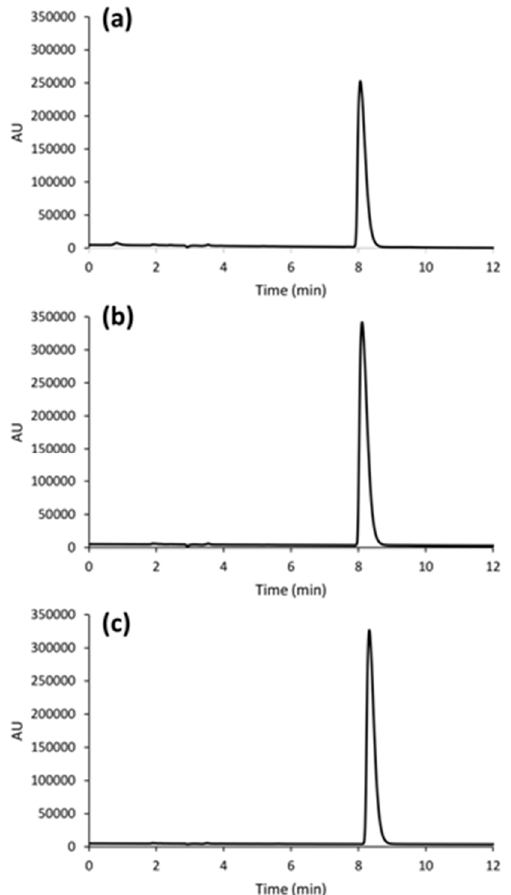
Figure 2. Achiral reversed-phase (RP)-HPLC chromatograms of ruxolitionib phosphase ( a ) standard solution, ( b ) obtained from the tablets, and ( c ) obtained from the capsule. All the analyses were performed on solutions made up with the active pharmaceutical ingredient (API) at ( a ) the test concentration or at ( b ) and ( c ) the expected test concentration. Experimental conditions: column, Robusta C18 (250 × 4.6 mm i.d., 5 μ m, 100 Å pore size); eluent, water/acetonitrile (ACN) (70:30, v / v ) with 0.1% v / v formic acid (FA) in both components; flow rate, 1.0 mL/min; column temperature, 25 °C. Y-axix is in arbitrary units (AU).